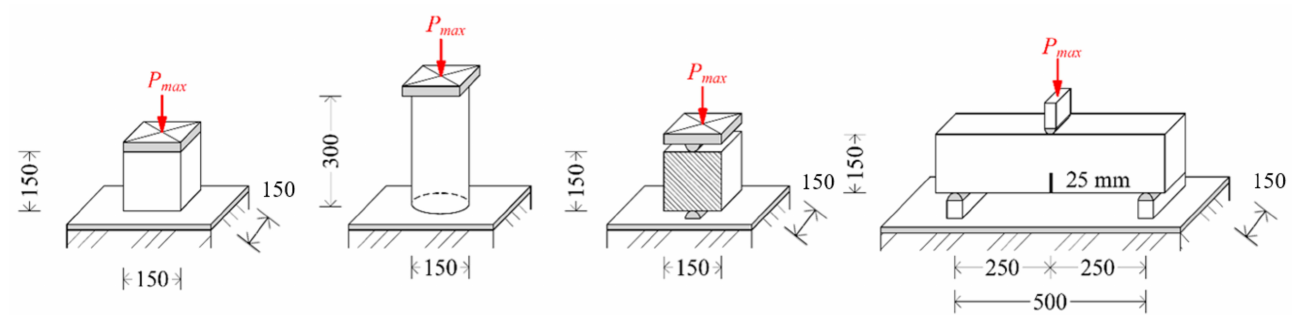
Figure 4. Test scheme of basic mechanical properties and bending test for concrete and fiber-reinforced concrete; cube 150 × 150 × 150 mm; cylinder 150 × 300 mm; beam 150 × 150 × 600 (700) mm, span 500